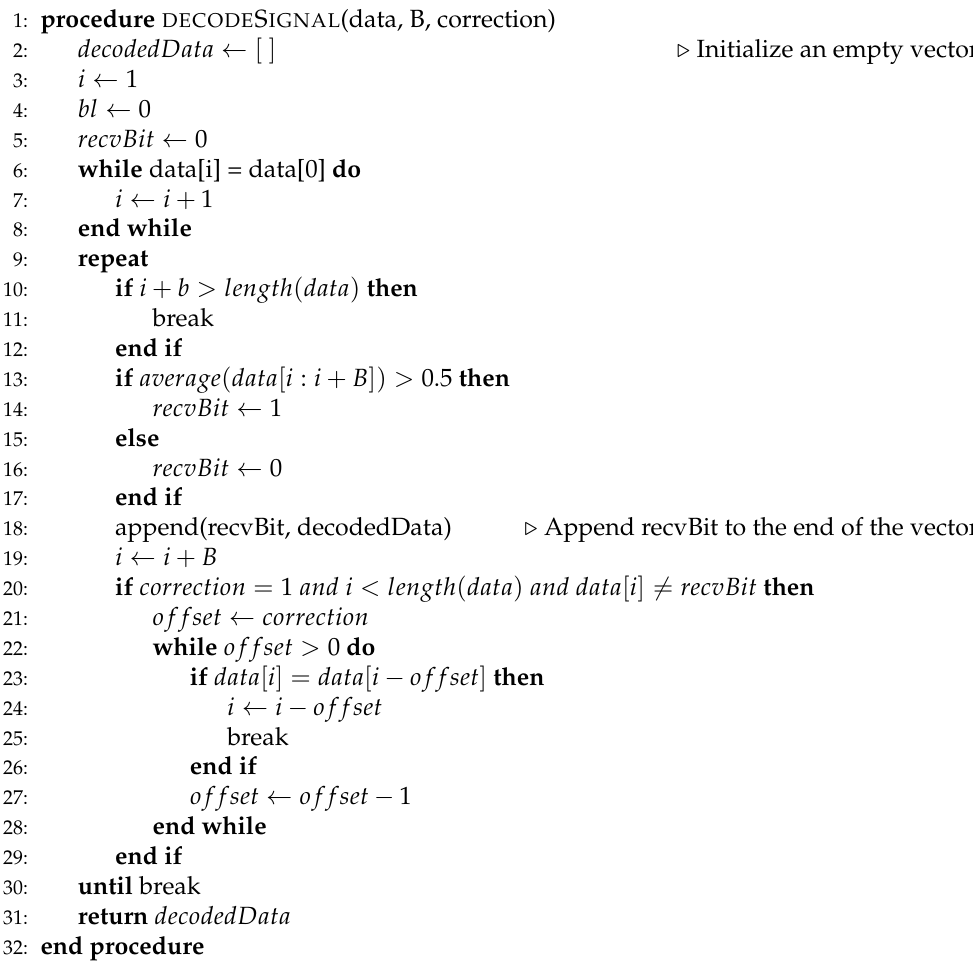
Algorithm 1 Decoding